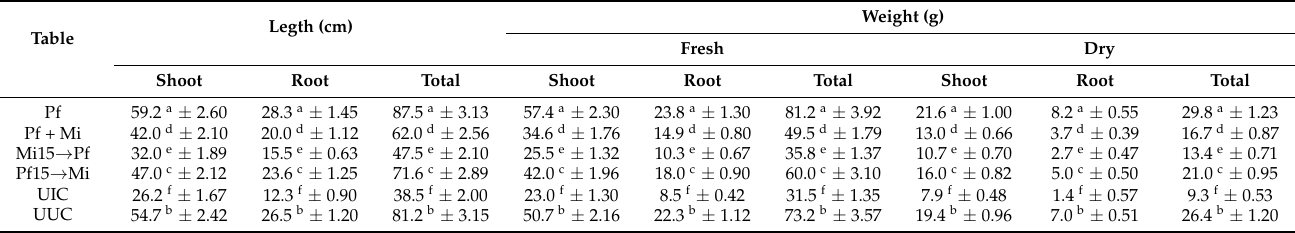
Table 1. Impact of individual, concomitant and sequential inoculation of Meloidogyne incognita and Pseudomonas fluorescens on plant growth parameters of tomato cv. K-21 in pots.